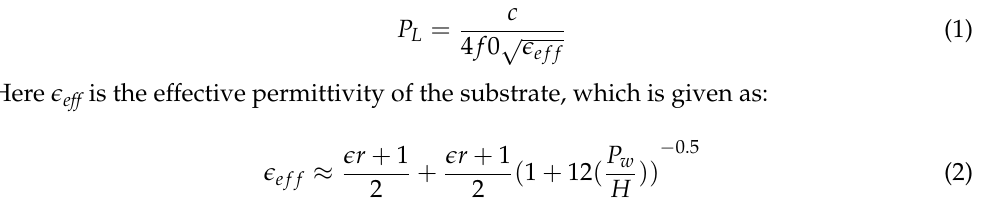
Figure 2. Different antennas are utilized to achieve the proposed UWB antenna design.